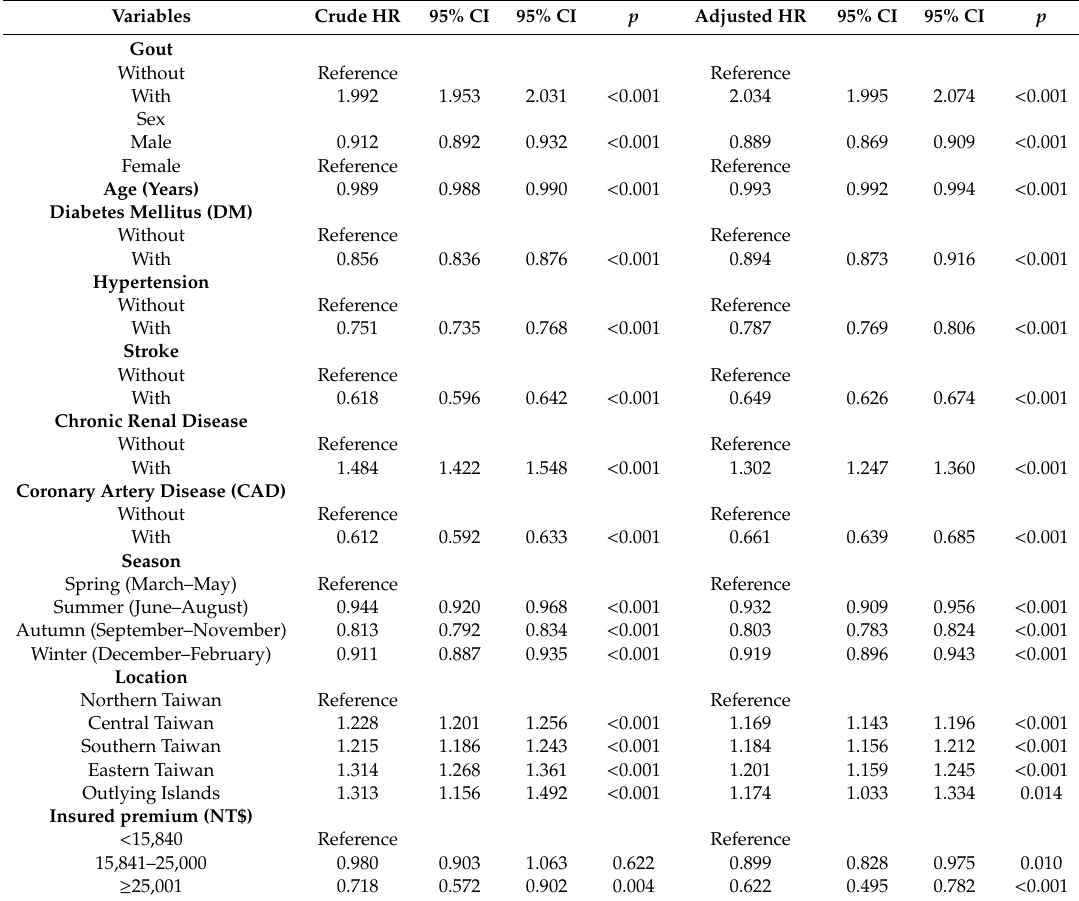
Table 3. Risk Factors for the Occurrence of